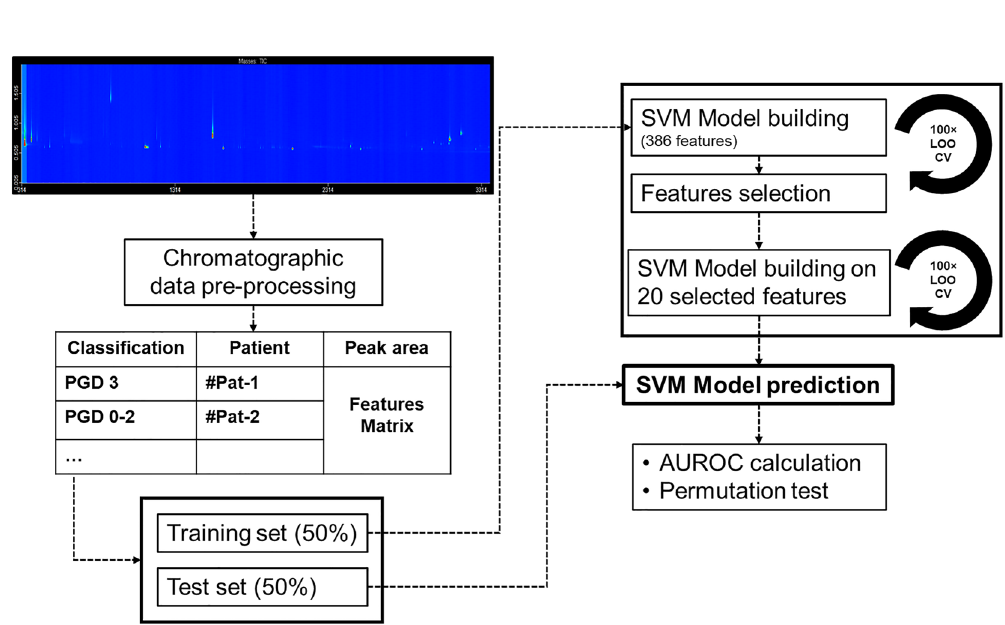
Figure 2. Feature selection, model building, and prediction. LOOCV: leave-one-out cross validation; SVM: support vector machine; AUROC: area under receiver operating